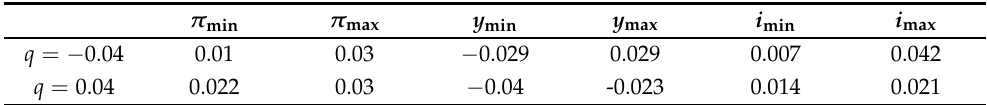
Table 3. Minimum and maximum viable values of inflation, output gap and interest rate (all in level terms) for v = 0.005. π min π max q = −